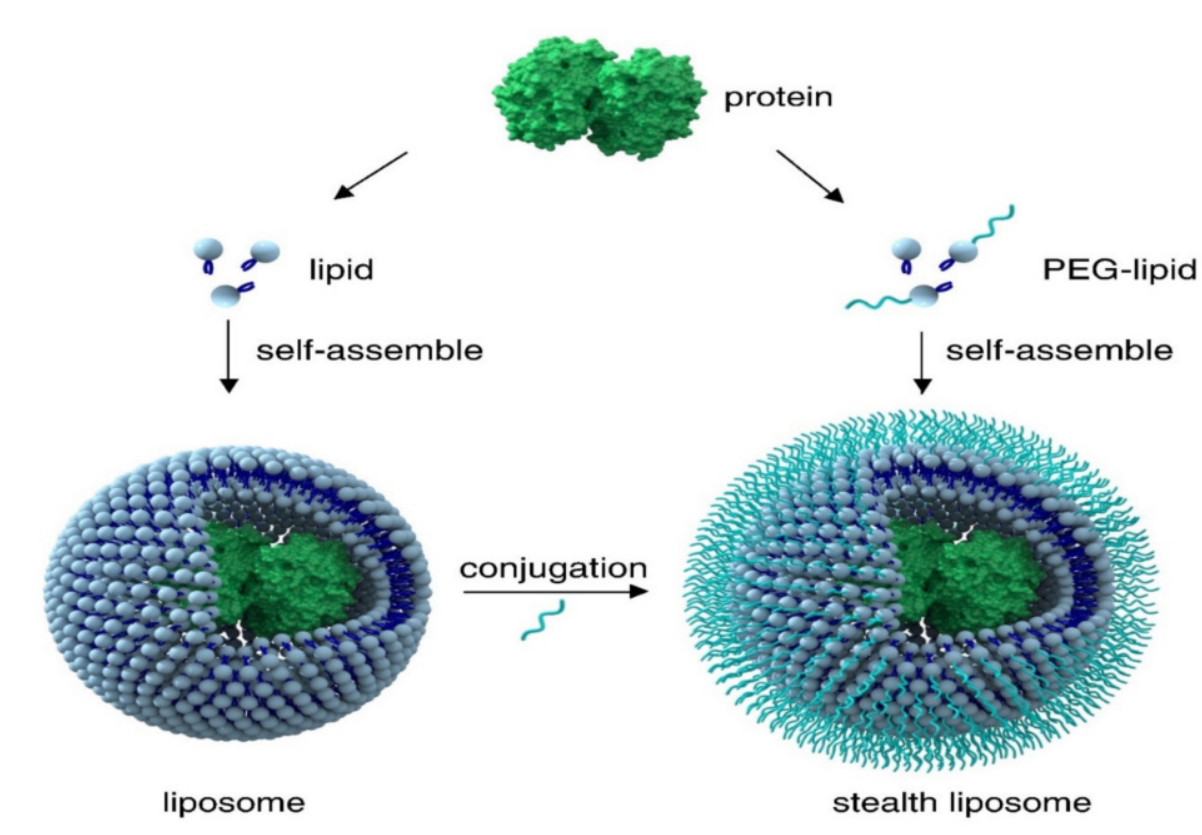
Figure 15. Formulation mechanism of stealth liposomes. Reprinted with permission from [212]; copyright (2022). Advanced Drug Delivery